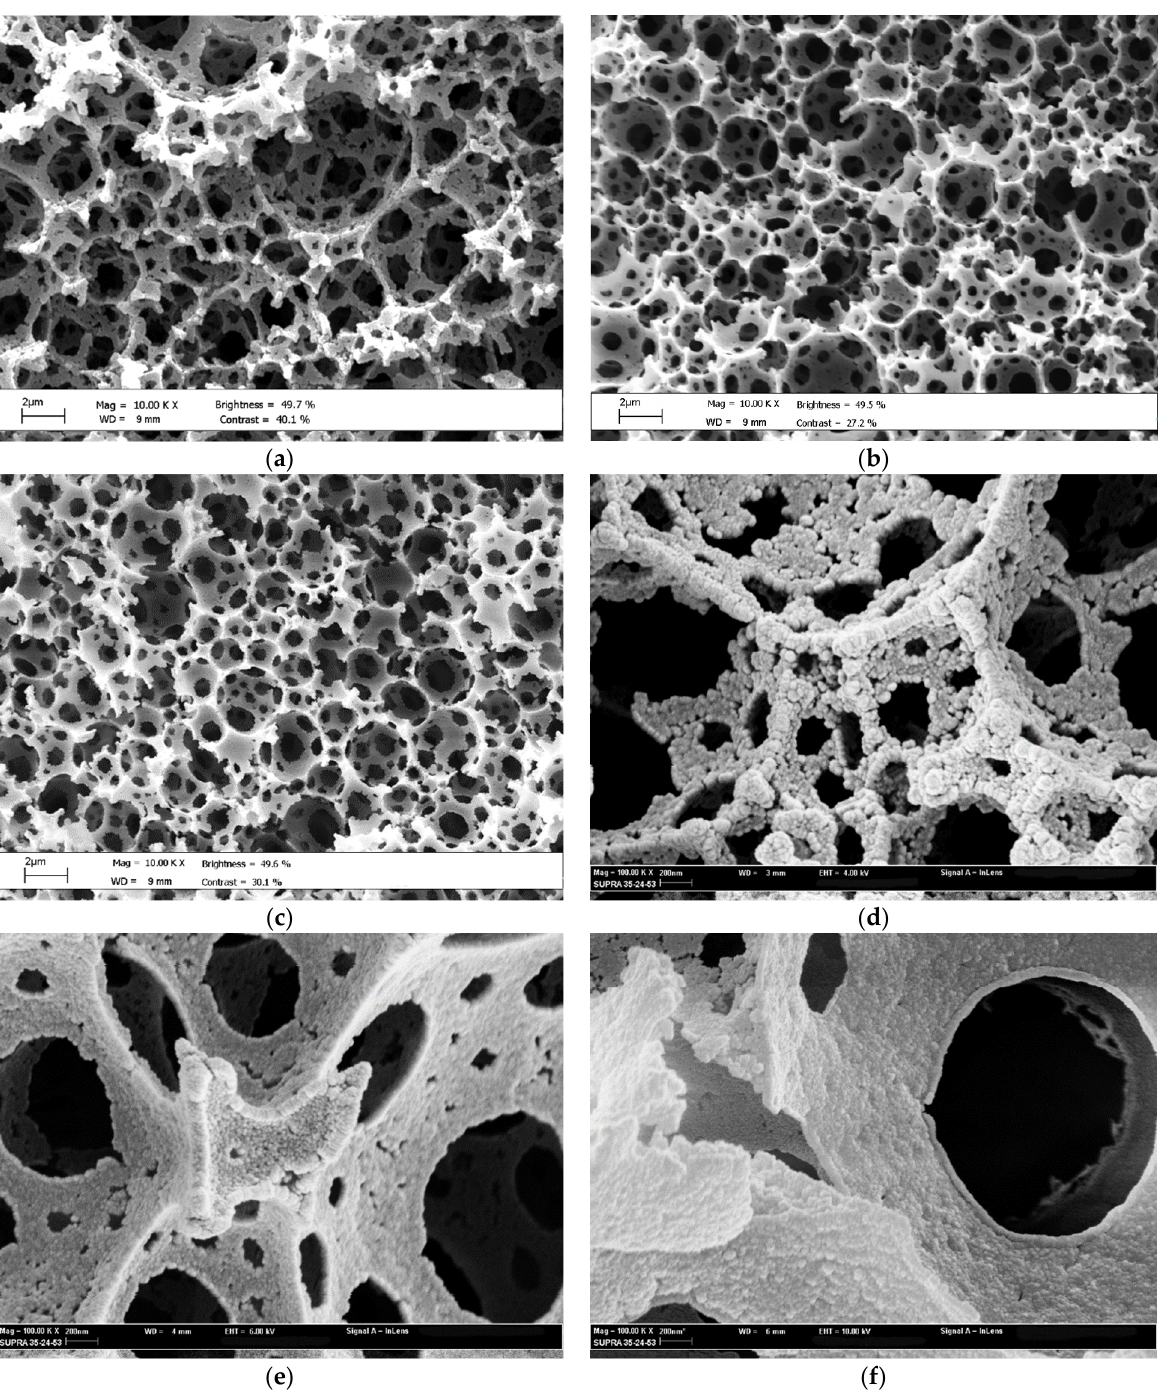
Figure 1. Scanning Electron (SEM) ( a – c ) and Field Emission Scanning Electron (FE-SEM) ( d – f ) mi- crographs of glycidylmethacrylate-divynilbenzene porous monoliths obtained through the High Internal Phase Emulsion (HIPE) technique. Sample in ( a , d ): GMA/DVB 80:20 (G80); sample in ( b , e ): GMA/DVB 60:40 (G60); sample in ( c , f ): GMA/DVB 40:60 (G40). Scale bars: ( a – c ), 2 µ m; ( d – f ), 200 nm. As evidenced from the high magnification micrographs ( d – f ), the samples have a granular texture. The dimension of particles decreases with the increase of the content of crosslinker.